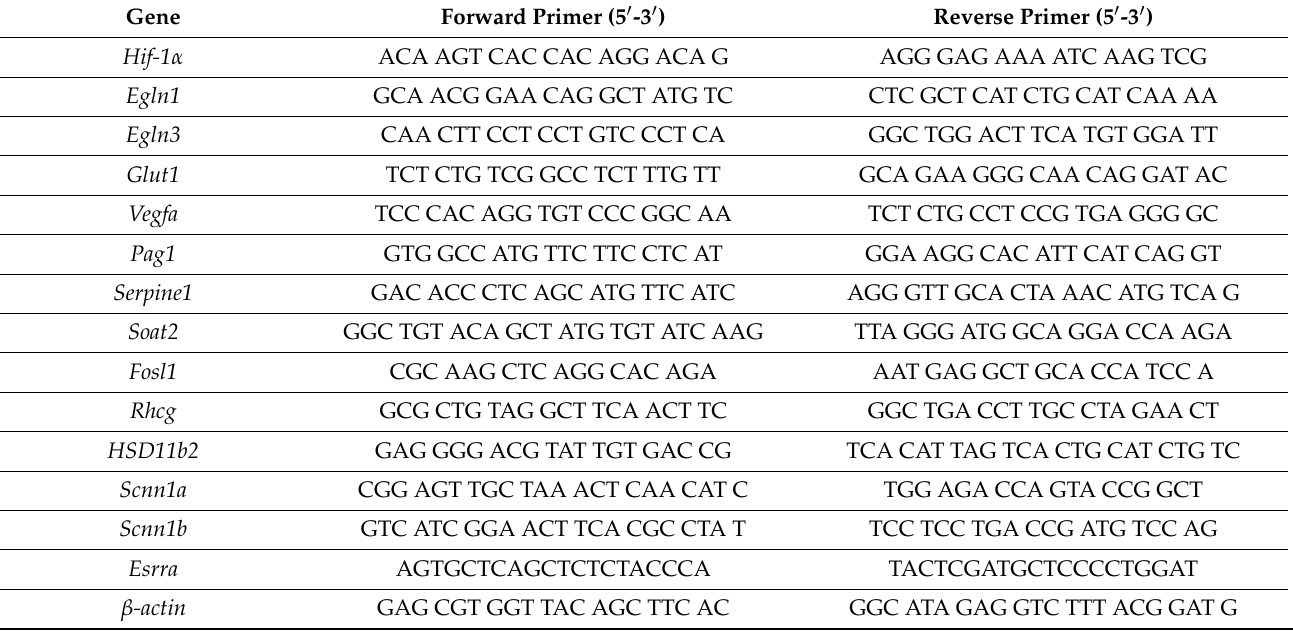
Table 1. List of mouse SYBRgreen primers used throughout the